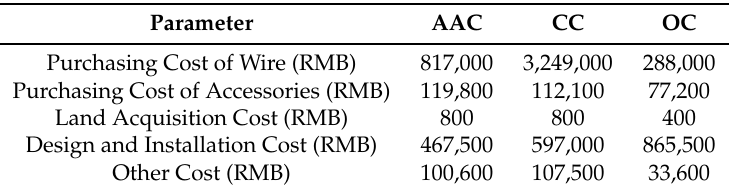
Table 6. Purchasing parameters in Case 2.